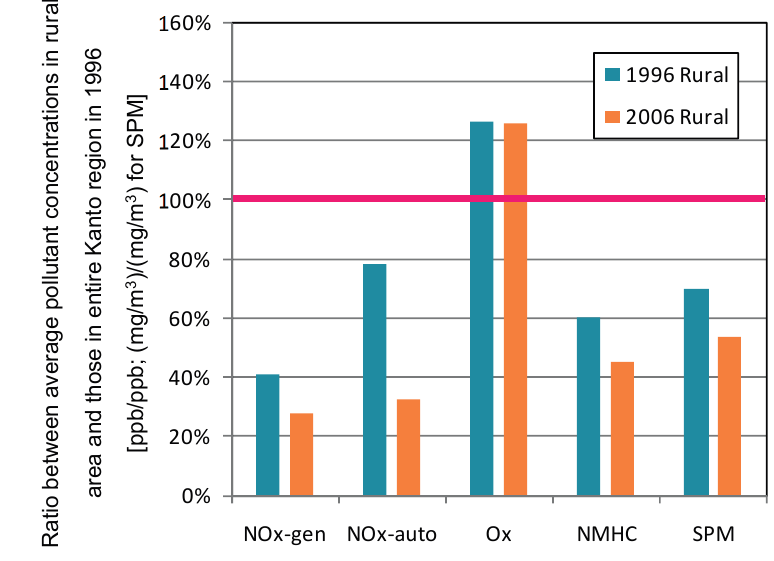
Figure 4. Ratio between average pollutant concentrations in rural area and those in the entire Kanto region in 1996. Average concentration of entire Kanto region in 1996 corresponds to